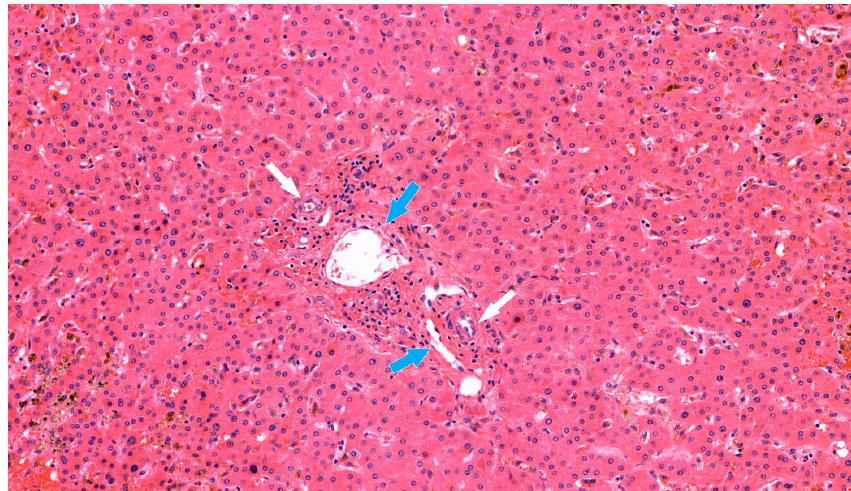
Figure 2. The liver allograft biopsy suggestive of chronic rejection (HE stain, 170×). In the portal tract, inflammatory cells were observed around hepatic artery (white arrow) and portal vein (blue arrow). Loss of interlobular bile duct was apparent with marked canalicular cholestasis.